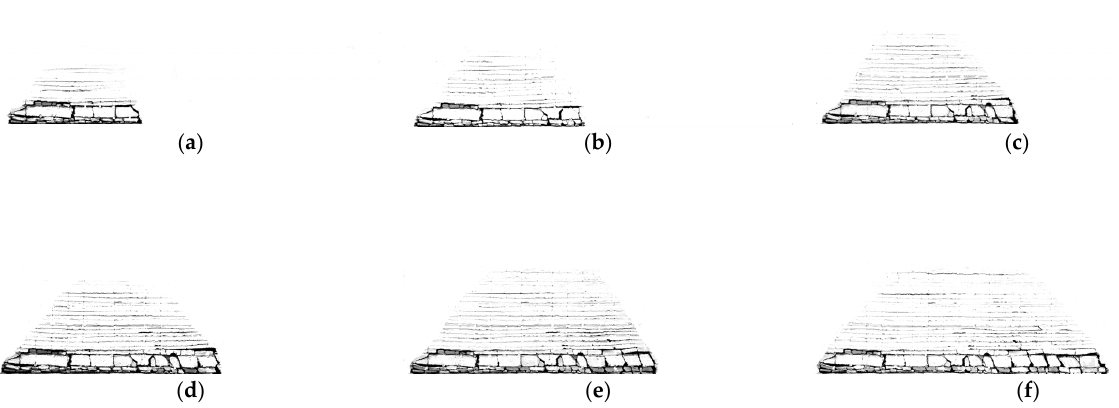
Figure 9. Extraction of fracture network of rock with different advancing distances. ( a ) Advancing distance 87 m; ( b ) Advancing distance 107 m; ( c ) Advancing distance 127 m; ( d ) Advancing distance 138 m; ( e ) Advancing distance 156 m; ( f ) Advancing distance 185 m.